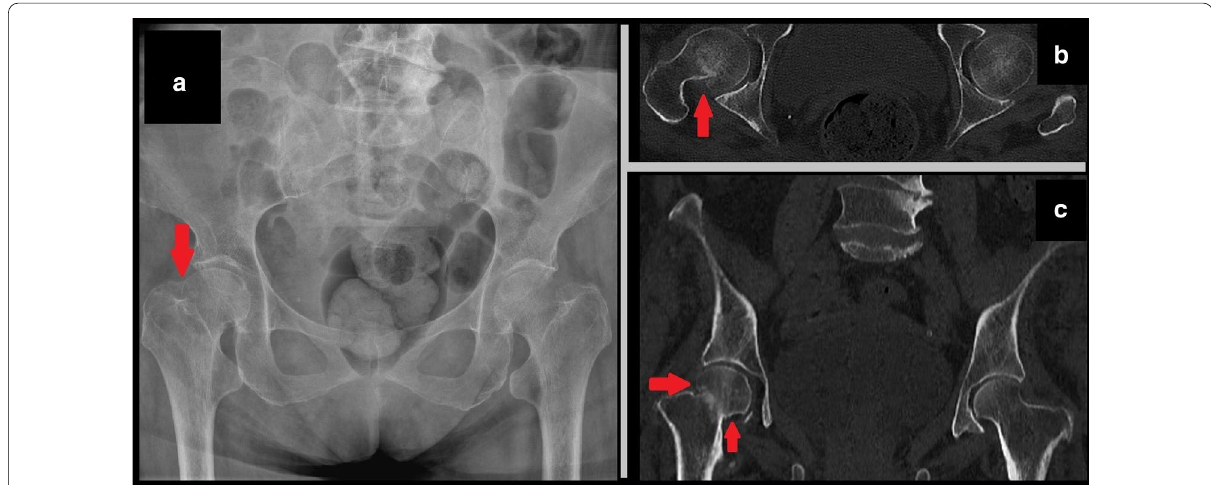
Fig. 6 Under-reading (type 4) error with inattentional bias (Gorilla effect). A female patient was admitted to the emergency department with bilateral hip pain after falling down stairs. X-ray and pelvic CT were interpreted as “normal” by the on-call radiologist. However, shortening of the right femoral neck (red arrow, a ) and a hyperdense line due to impacted fracture (red arrows, b , c ) were missed. After retrospective detection of fracture, the radiologist was asked about the cause of missing these findings. He stated that he did not expect to see a hyperdense impaction fracture at all while evaluating that particular case. The prejudice of “fractures are seen as hypodense lines” caused inattentional blindness. A hyperdense fracture line is an uncommon finding, and due to its unexpected nature, may result in an under-reading error